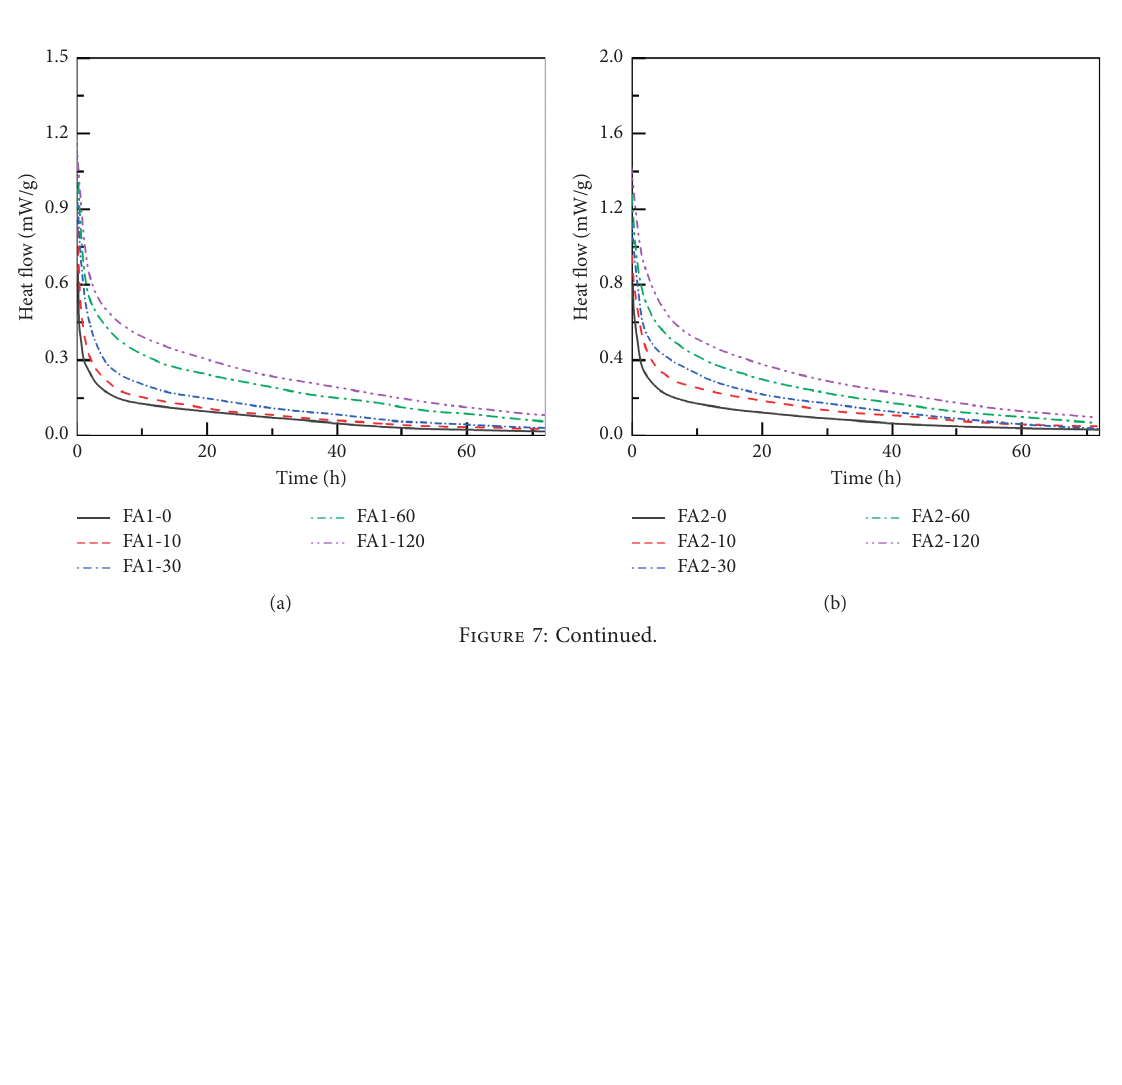
Figure 6: Dissolution characteristics of the fly ash: (a) FA1 and (b) FA2.